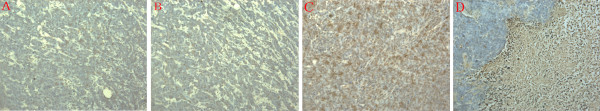
Cell death in implanted tumor tissues. Cell death was detected by TUNEL assay in implanted tumors treated with NS(A), Ad-HK(B), or Ad-RhoA-RhoC(C and D). Original magnification, ×200. The nuclei of positive cell were stained brown.